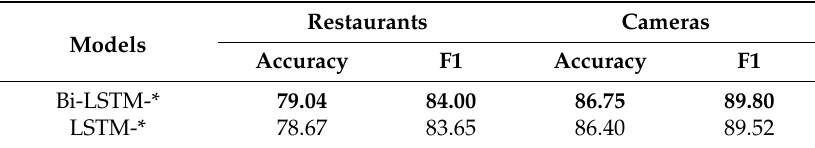
Table 3. Contrast experiment data of Bi-LSTM-* and LSTM-* on Restaurants and Cameras datasets. Evaluation metrics are accuracy and F1 measure. Best scores are in bold.